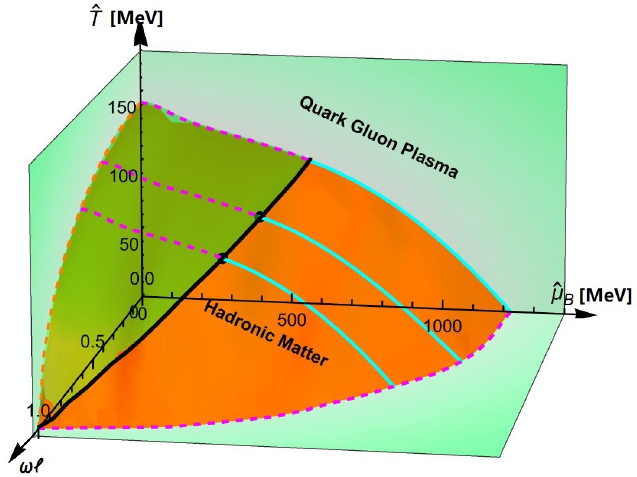
Figure 6 . The phase diagram of rotating QCD matter in our 2+1 flavor model. The orange and green surfaces show the phase boundaries for the first-order phase transition and crossover, respectively. The black line denotes the location of the CEP. The phase boundary for the first-order phase is uniquely determined by the swallow tail behavior of free energy, while the case for the crossover is obtained by the minimum of the squared speed of